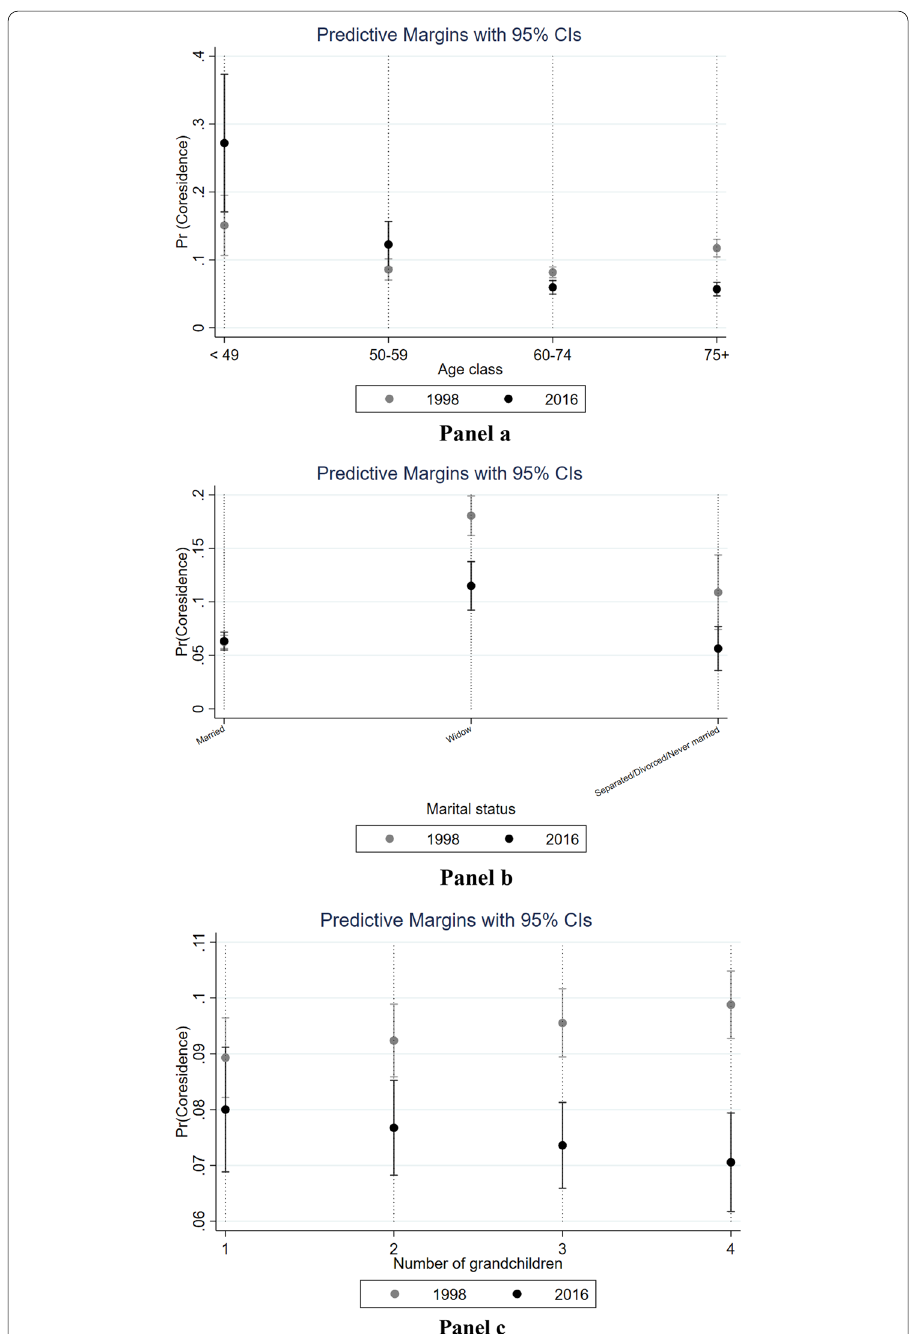
Fig. 1 Predicted probabilities coresidence—changes over